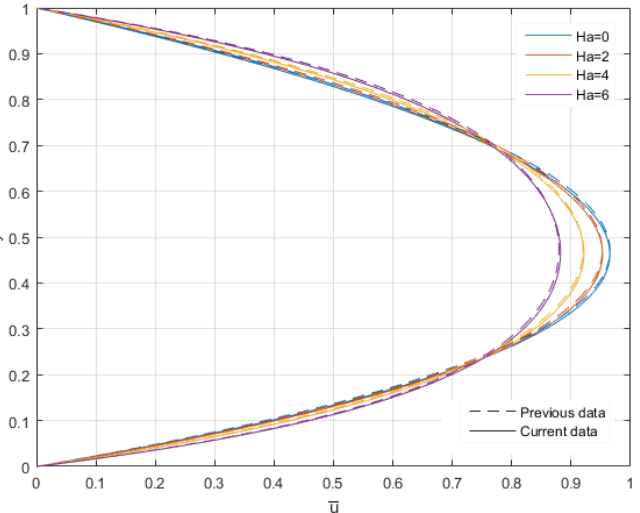
Figure 3. Comparison of the predicted steady-state velocity profiles at the midplane channel at different Hartman numbers between the present model and the published work [25].